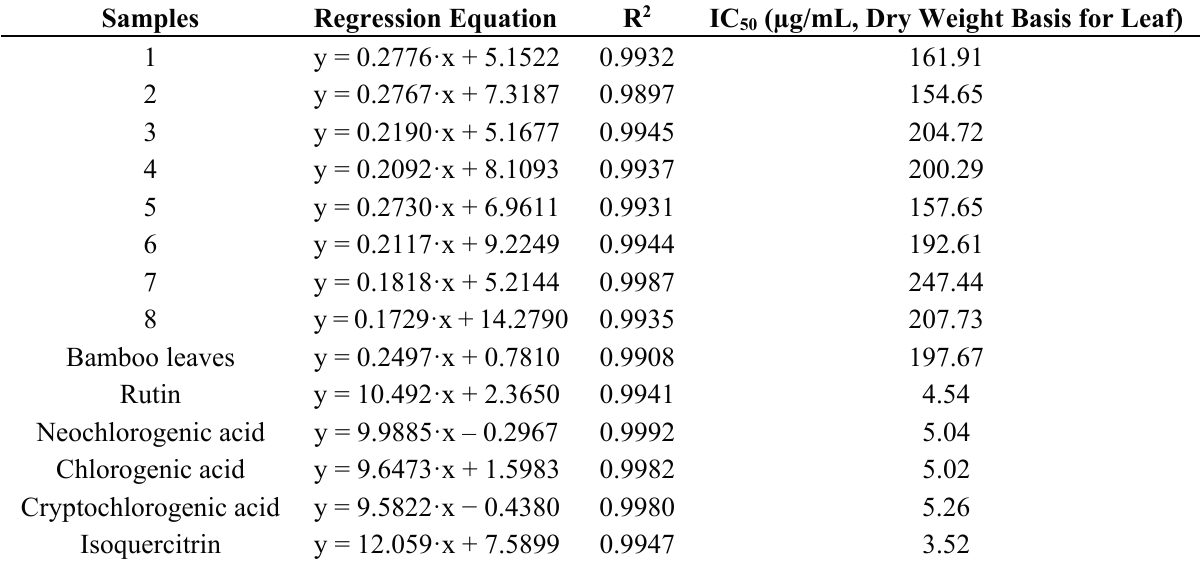
Table 7. Antioxidant activity of the eight accessions of H. sabdariffa. Sample No. corresponds to Table